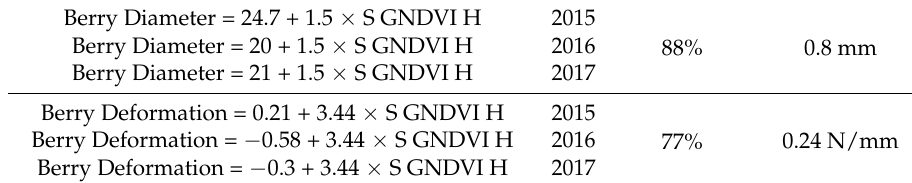
The values of adjusted R 2 and RMSE refer to all three years of this study.